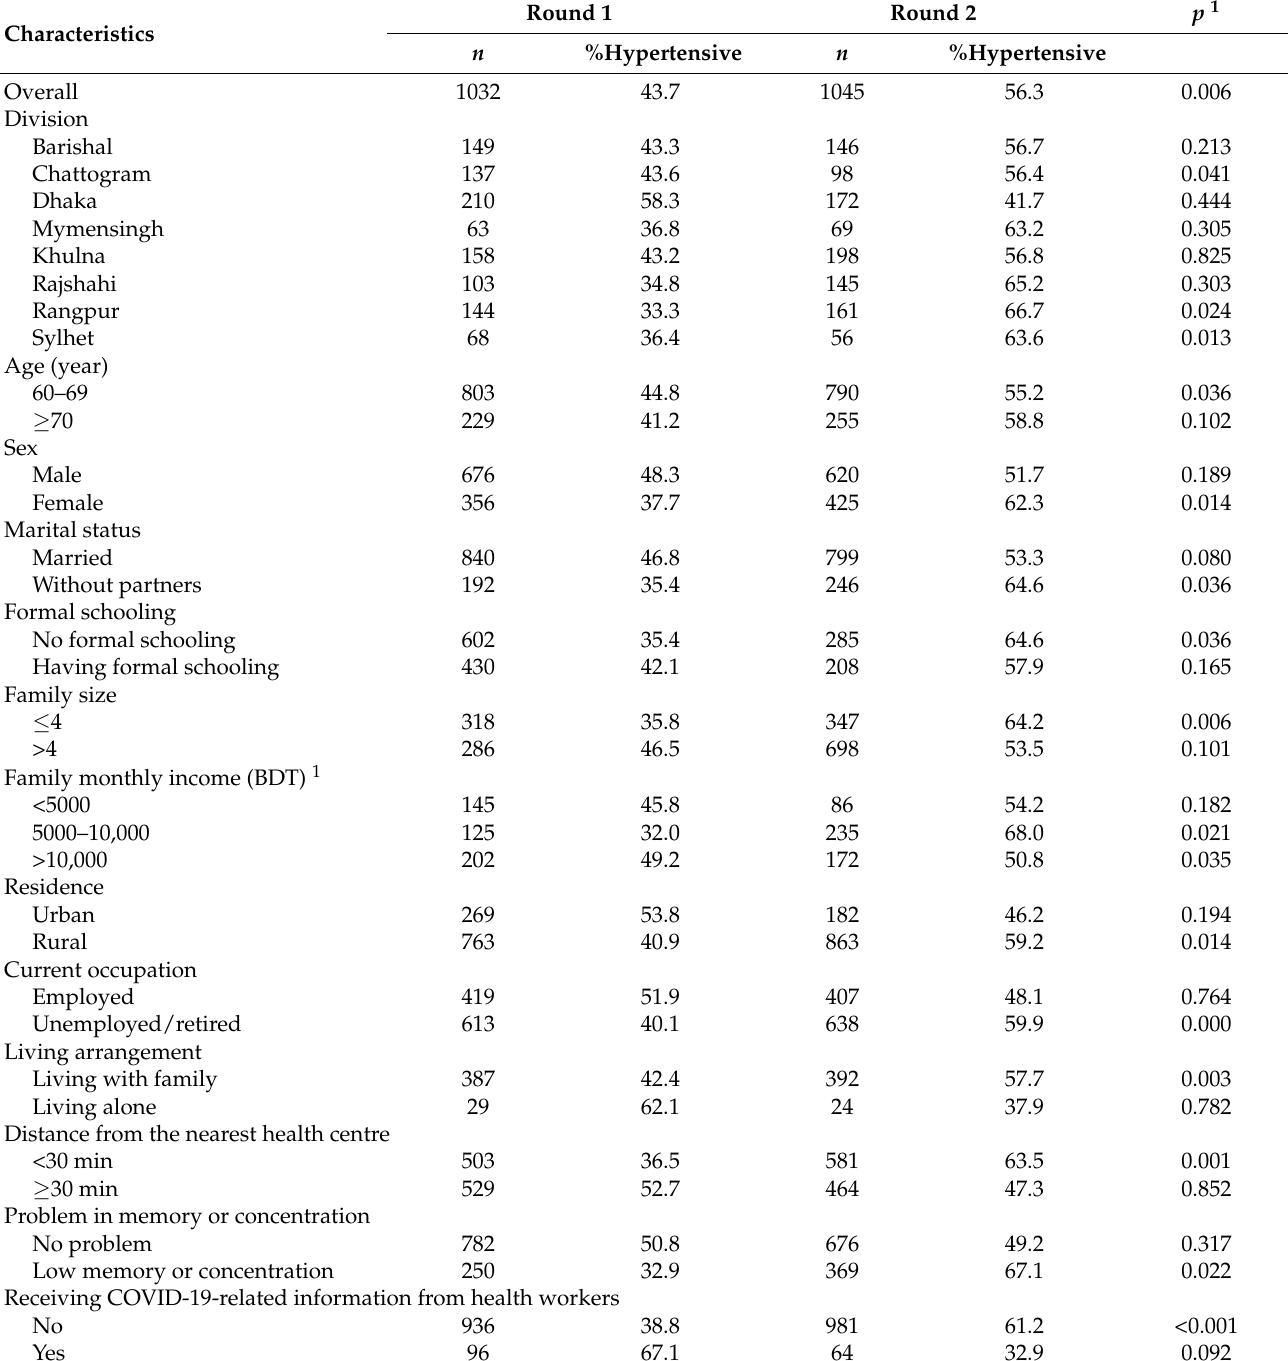
Table 2. Change in hypertension prevalence over the time ( n =